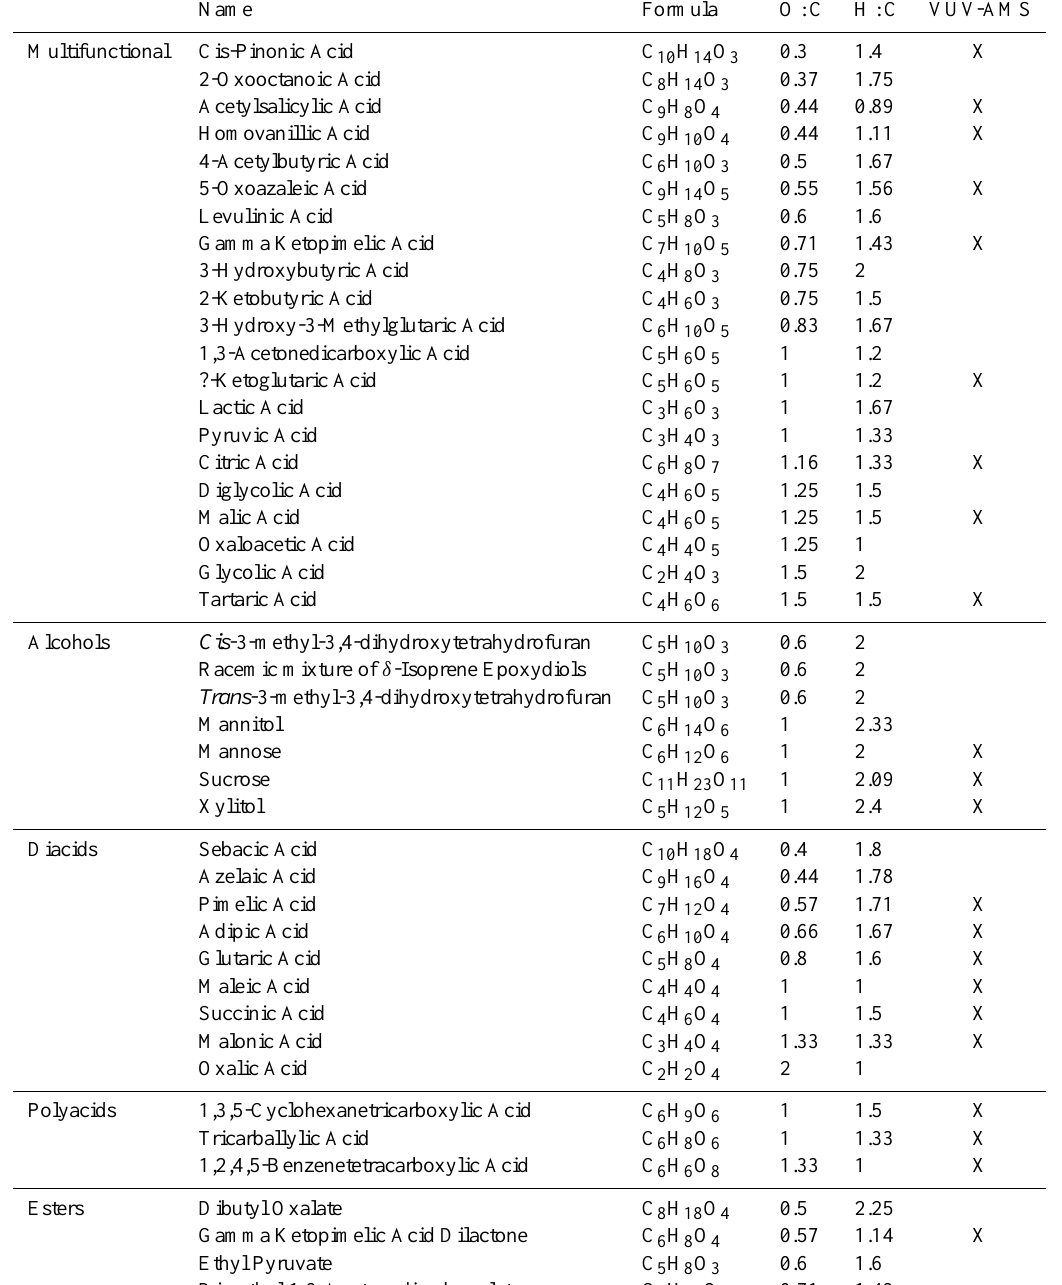
Table 1. A list of standards analyzed in this study and their molecular O:C and H:C ratios. Standards are categorized according to their functionality into broad groups. All standards were studied with EI AMS, while standards also studied with VUV-AMS are noted in the last